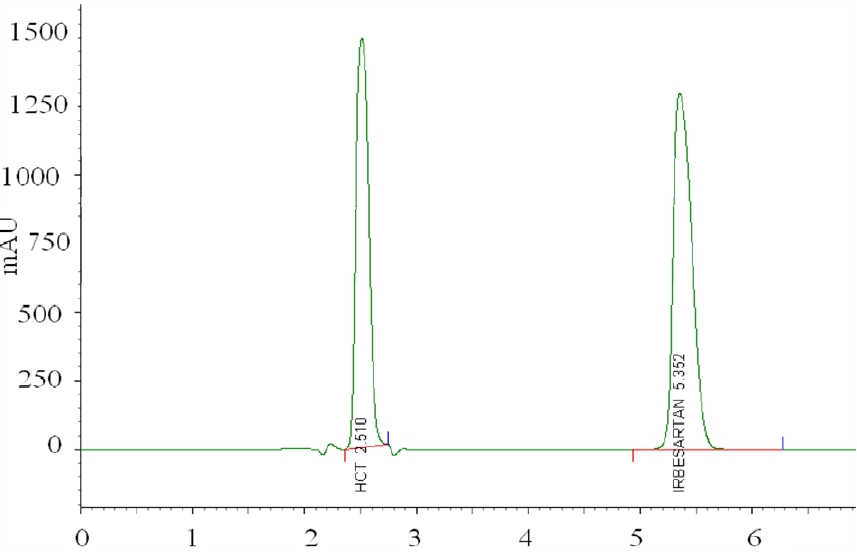
Figure 7. LC-PDA chromatogram of hydrochlorothiazide and irbesartan taken under optimized experimental